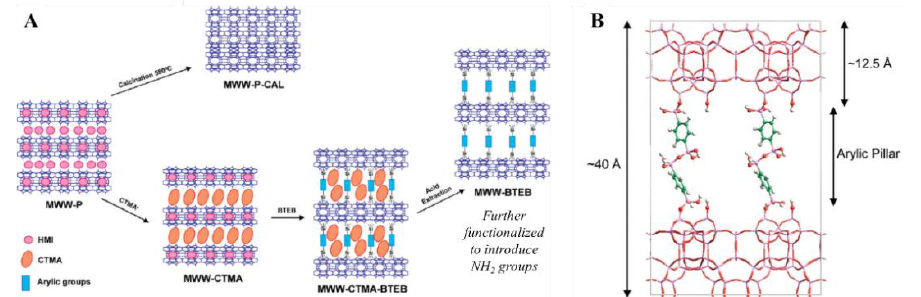
Figure 27. ( A ): Synthetic procedure implemented for the synthesis of the pillared hybrid zeolitic materials from MWW precursors. ( B ): Layered hybrid material obtained by pillaring with BTEB silsesquioxane molecules (MWW-BTEB). Reprinted with permission from [126]. Copyright 2010, American Chemical Society.